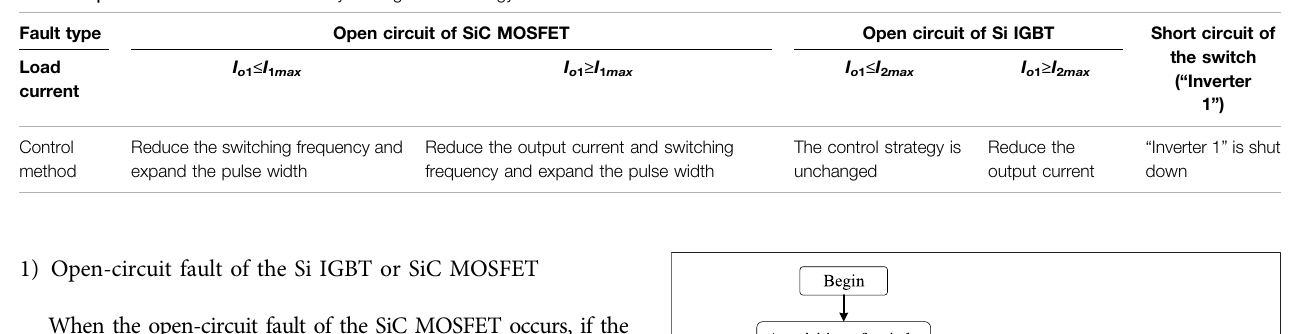
TABLE 1 | Classi fi cation of the redundancy management strategy of the switch level.